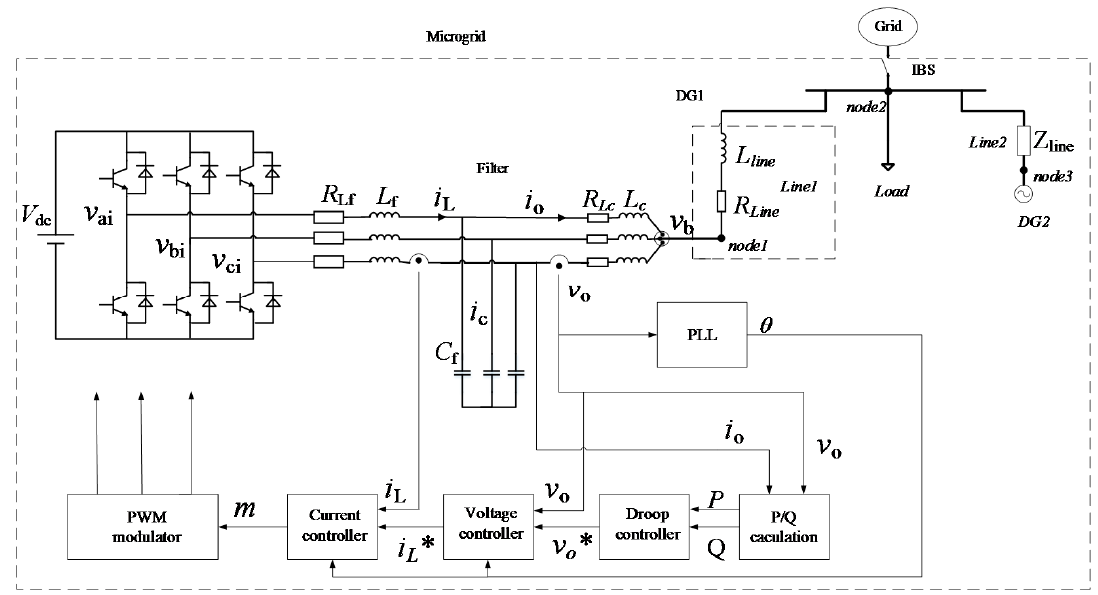
Figure 1. Structure and control structure for a microgrid (MG). IBS: intelligent bypass switch; PWM: Pulse-Width Modulation; PLL: Phase Locking Loop.